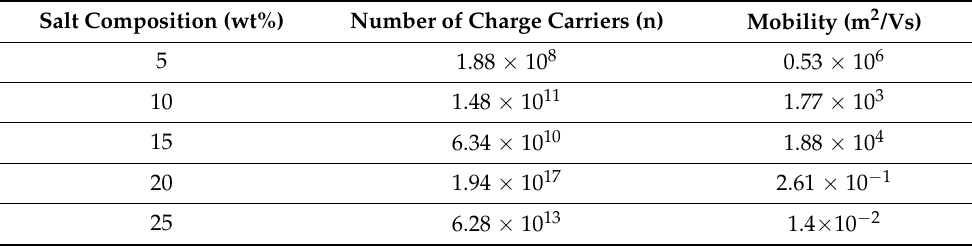
Figure 8. The dependence of the number of charge carriers and mobility on the amount of the NaSCN in the PVA: PVP (50:50 wt%) PE system. Table 3. Values of the number of charge carriers and mobility for different contents of NaSCN in the PVA: PVP (50:50 wt%) polymer salt